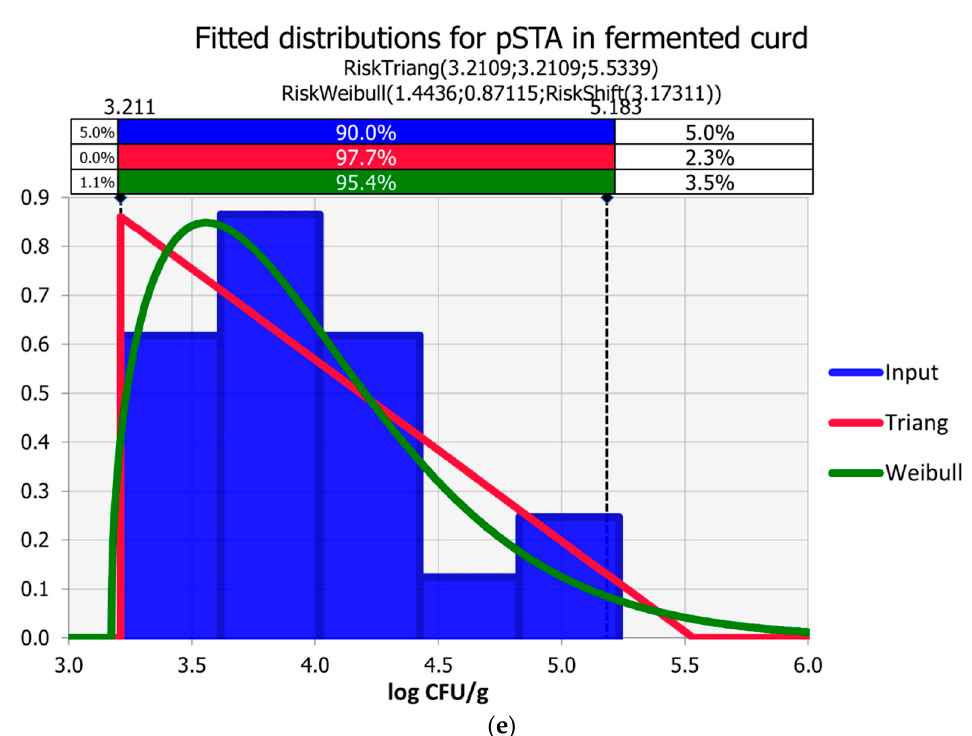
Figure 5. Fitted distributions for microbiological indicators in fermented curd: ( a ) TVC; ( b ) Y&M; ( c ) CFM; ( d ) EC; ( e ) pSTA.